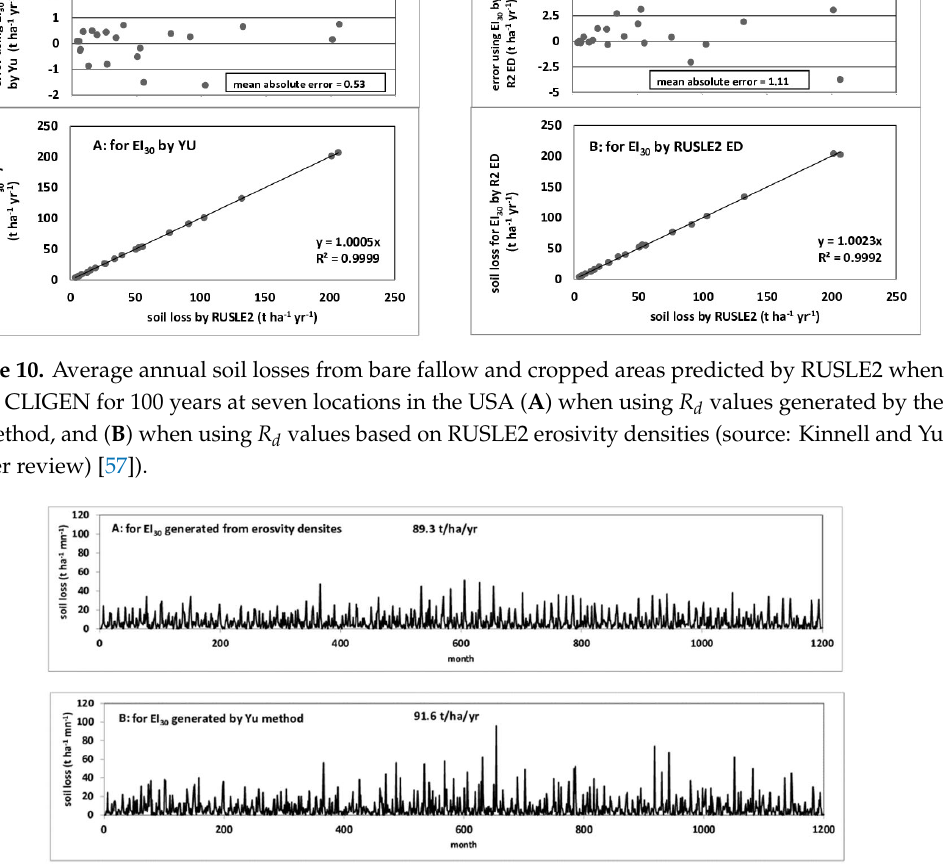
Figure 11. Monthly soil loss values for cotton at Holly Springs generated by CLIGEN ( A ) for EI 30 values generated from RUSLE2 erosivity densities, and ( B ) for EI 30 values generated by the Yu method.